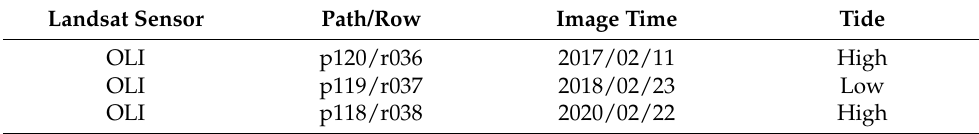
Table 1. Images used in the